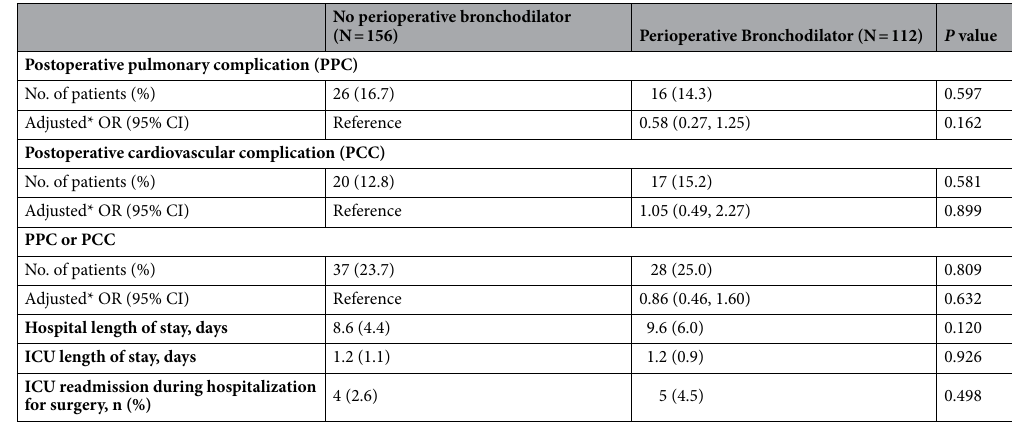
Table 4. Postoperative complications and hospital length of stay according to perioperative bronchodilator. Values in the table are n (percent), mean (standard deviation) or adjusted odds ratio (95% confidence interval). *Adjusted for age, sex, body mass index (underweight, normal, overweight, or obese), smoking status (never, past, or current), surgical extent (limited resection, lobectomy, bilobectomy, or pneumonectomy), VATS, preoperative baseline FEV 1 (mL) and DLco (%